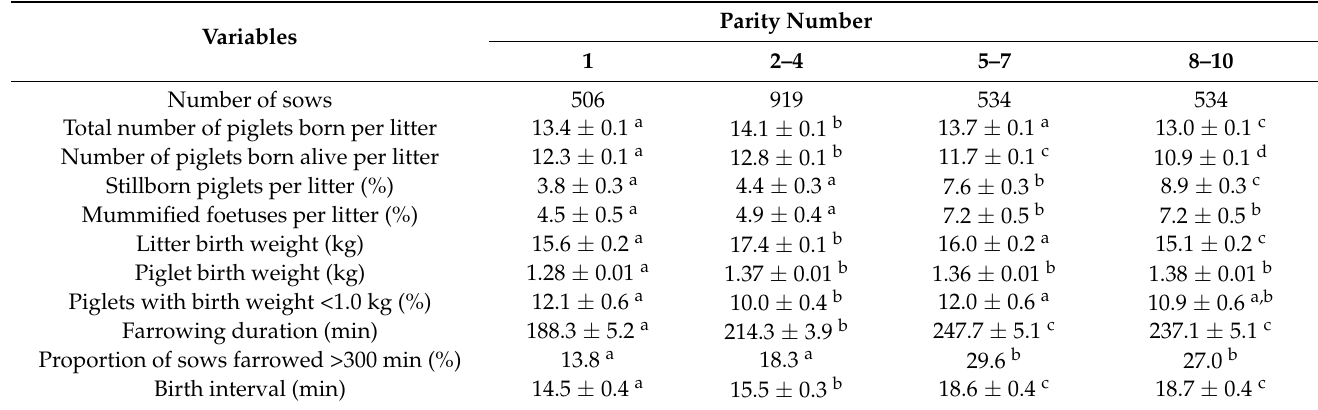
Table 4. Reproductive performance and farrowing characteristics of sows by parity